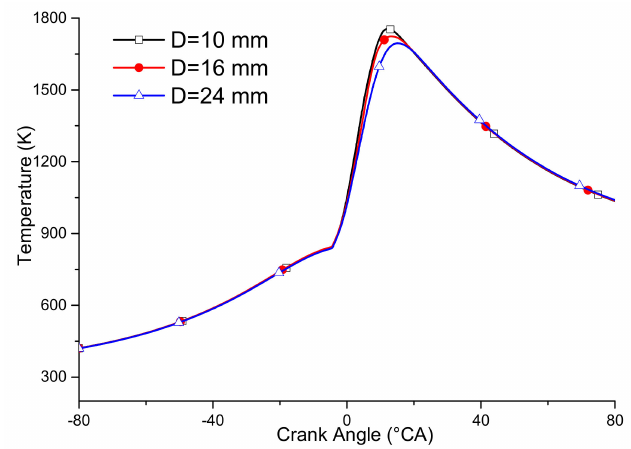
Figure 12. Mean in-cylinder temperature at di ff erent PCC nozzle